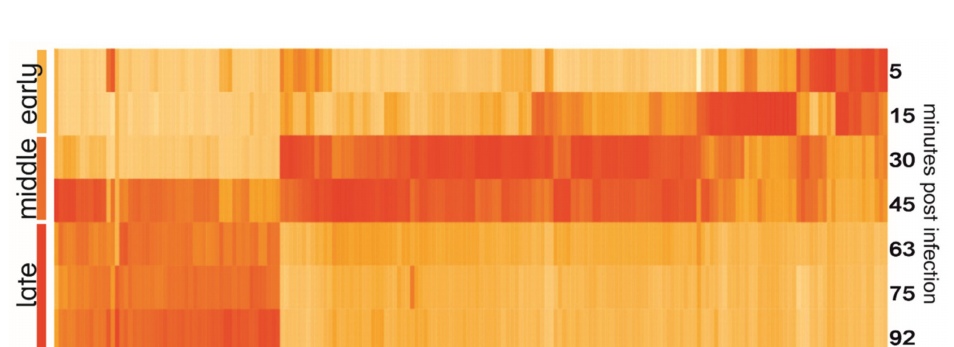
Figure 3. Heatmap of YerA41 genes expressed at di ff erent time points post infection. Gene expression values were normalized to the highest expression to show the timing of expression; therefore, the intensity of color on the heatmap reflects the di ff erence of expression of one gene at di ff erent time points, yet not the di ff erence of expression between di ff erent